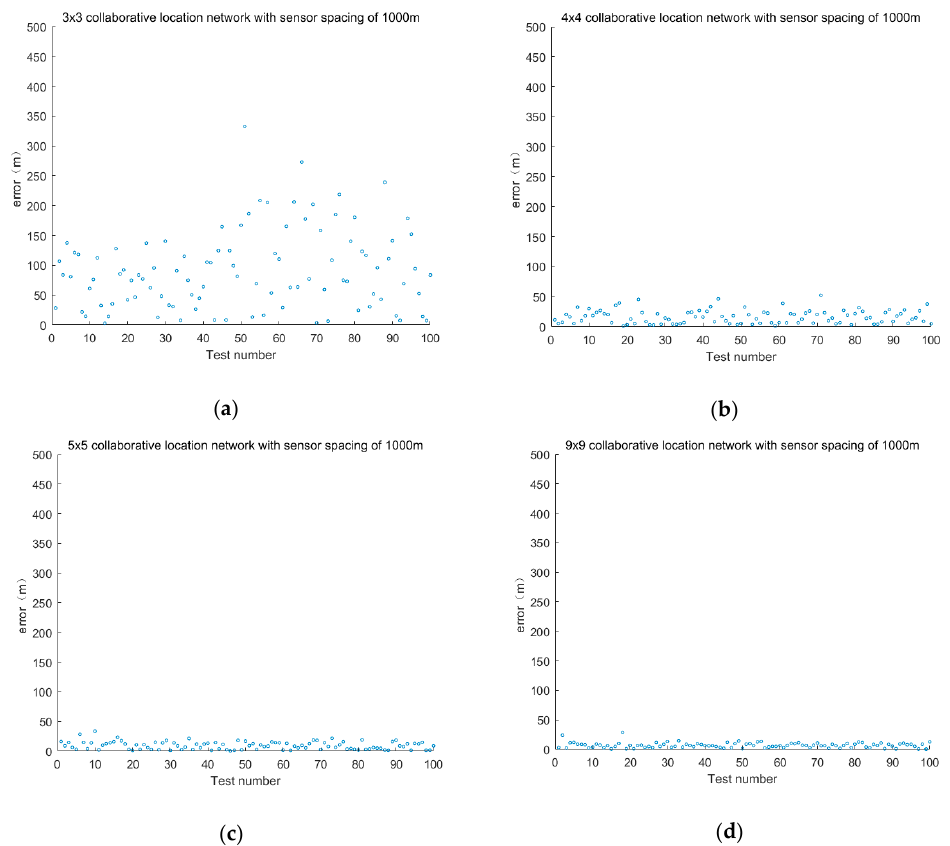
Figure 10. Positioning error of cooperative location network with different layouts of sensors at 1000 m intervals.